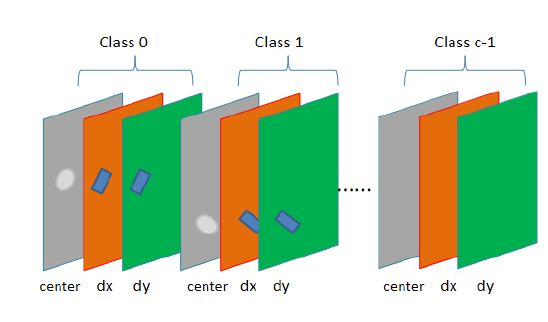
Figure 5. 3c feature maps for c classes object field